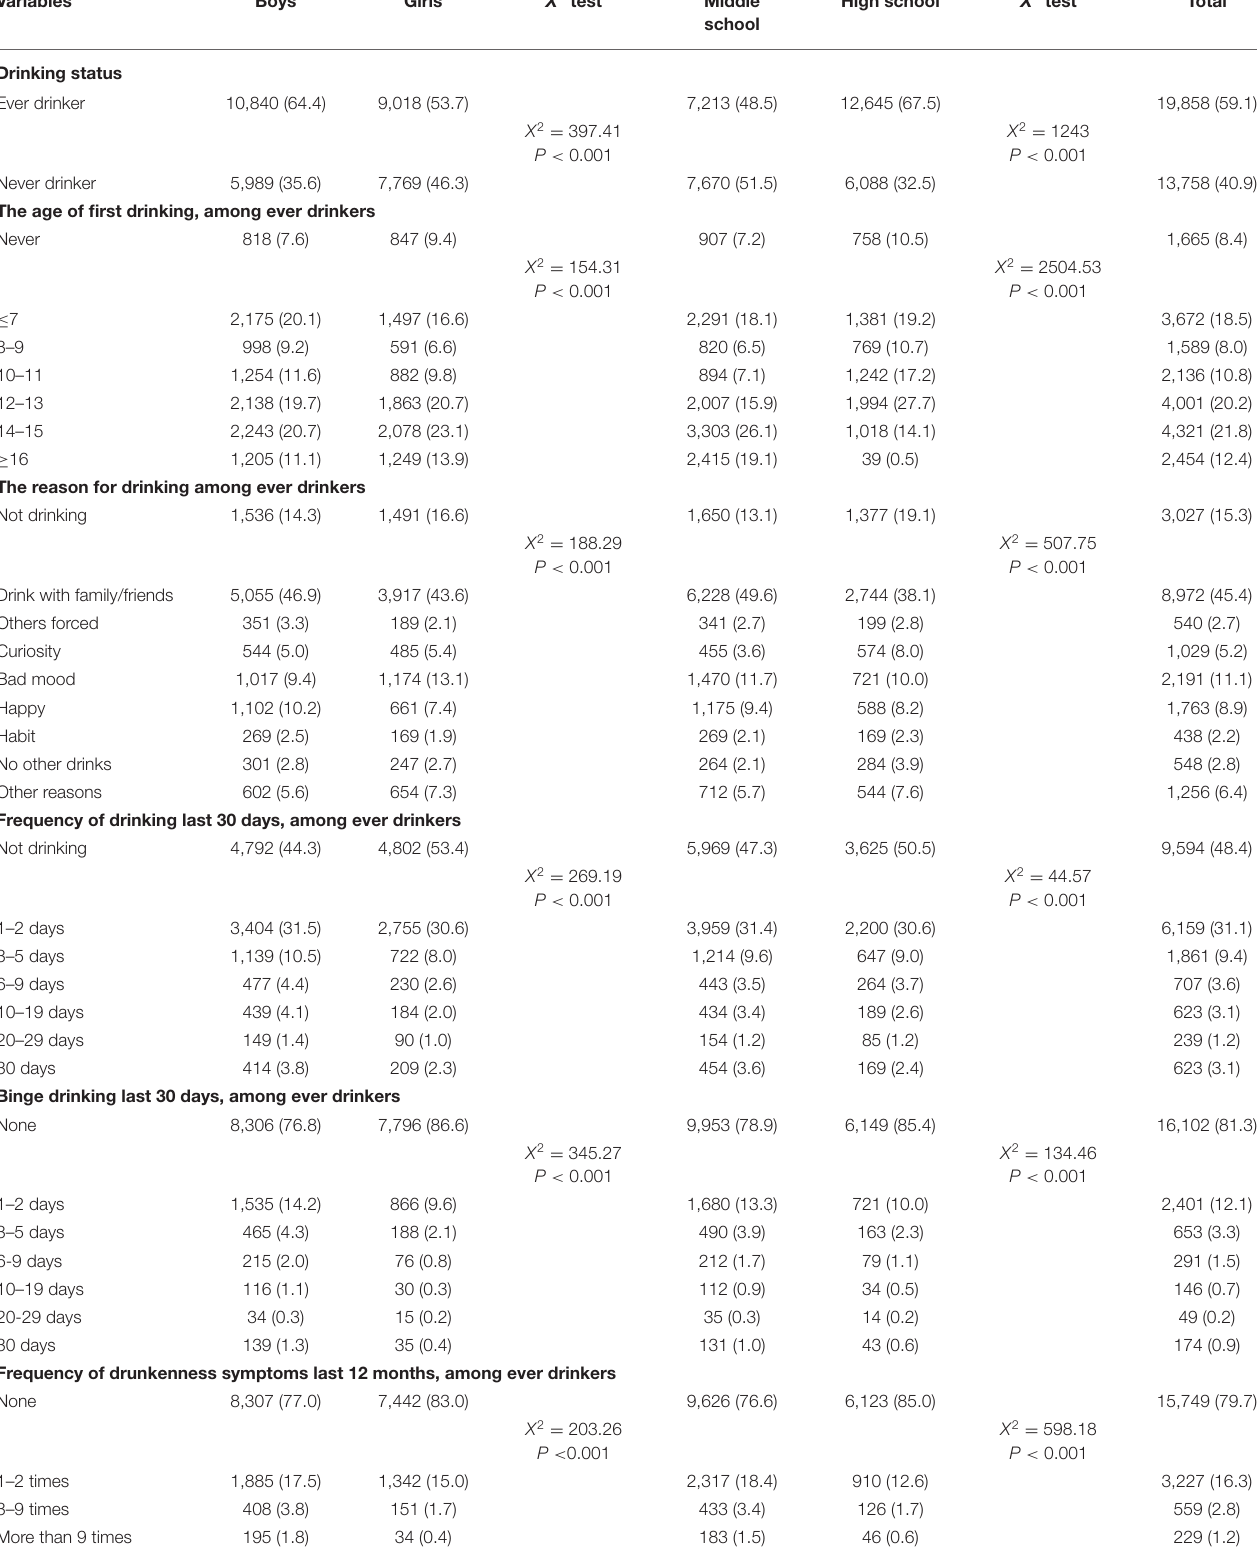
TABLE 2 | Characteristics of alcohol consumption and binge drinking by gender and school level, N (%).